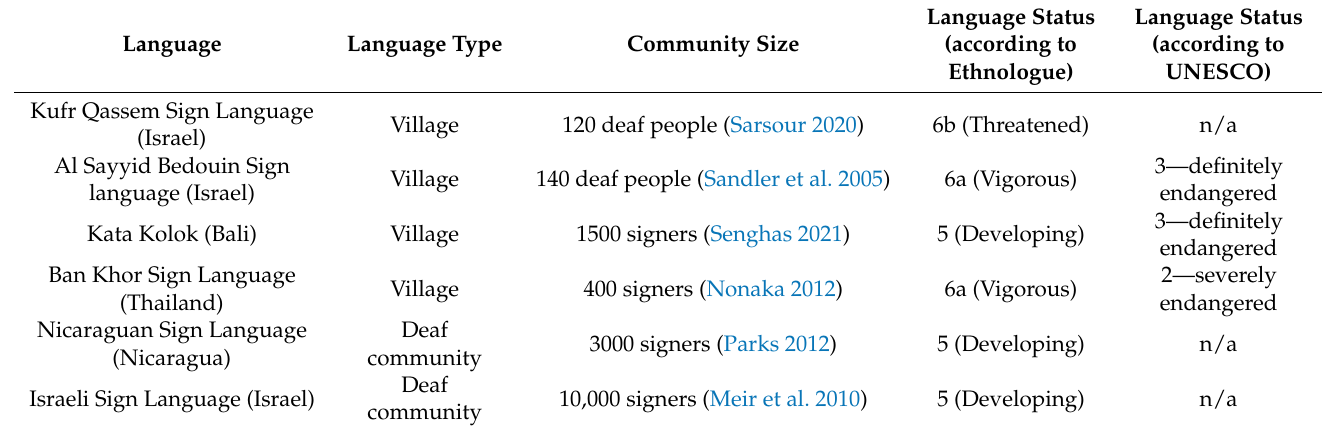
Table 2. Ethnolinguistic status of several sign